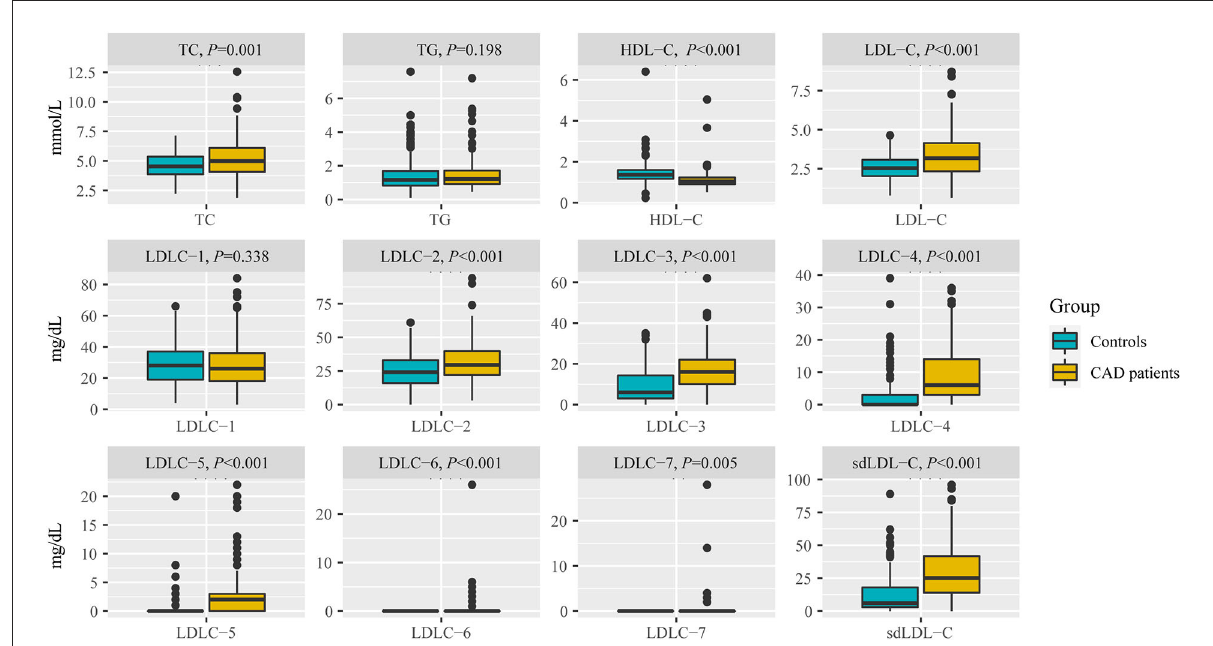
FIGURE3 Comparison of blood lipids between non-CAD controls and patients with CAD, including TC, TG, HDL-C, LDL-C, LDLC-1 to LDLC-7, and sdLDL-C. TC, total cholesterol; TG, triglyceride; HDL-C, high-density lipoprotein cholesterol; LDL-C, low-density lipoprotein cholesterol; sdLDL-C, small dense low-density lipoprotein